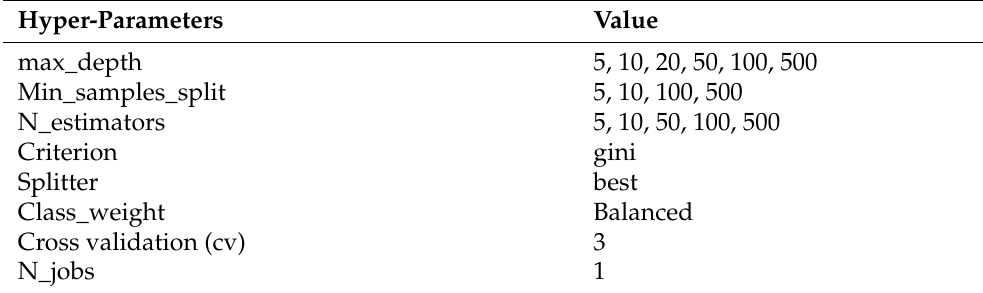
Table 4. Input Parameters for Decision